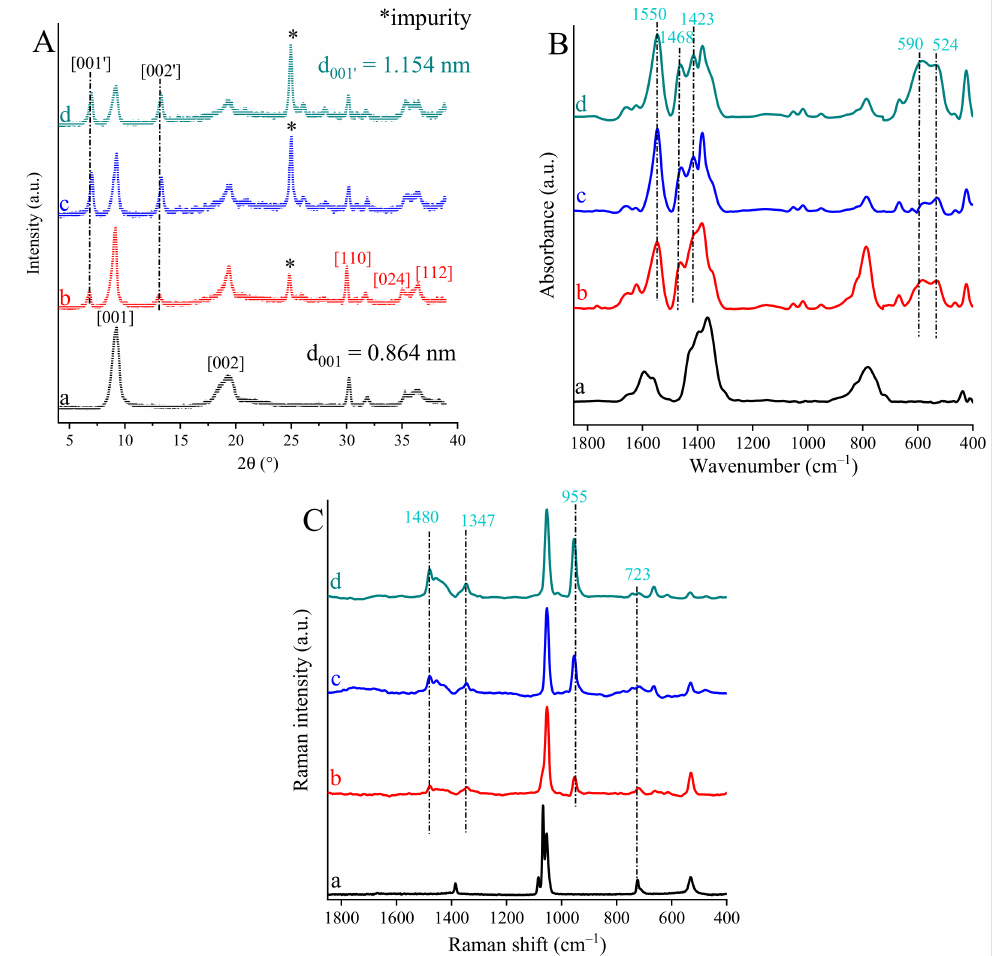
Figure 5. XRD patterns ( A ), IR ( B ) and Raman spectra ( C ) of CaAl–cysteinate–LDH (a) and CaAl– cysteinate–LDH (0.1 g) oxidized by peracetic acid upon using 0.4 M (b), 0.55 M (c) and 0.65 M (d) peracetic acid in acetone (100 cm 3 ) at 298